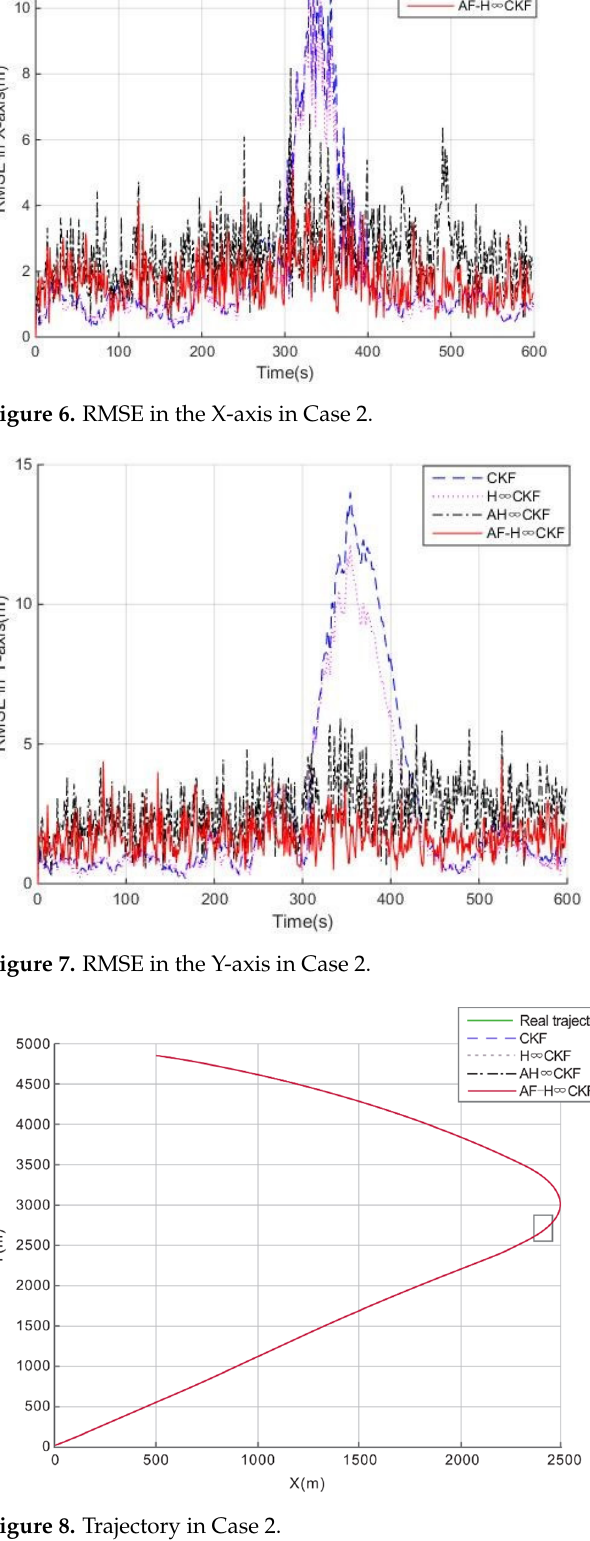
Figure 9. Partial enlargement of Figure 8.